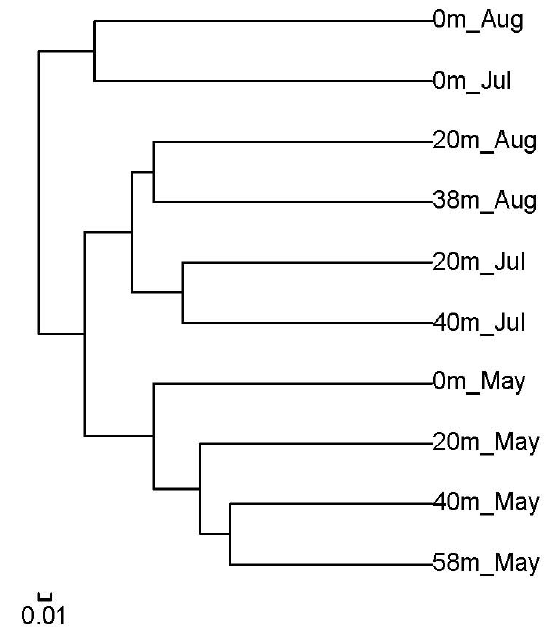
Figure 6. Clustering analysis of pyrosequencing profiles based on the Bray-Curtis similarity from the operational taxonomic units (OTUs) compositions (97%